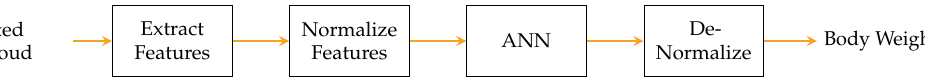
Figure 2. Process of body weight estimation.